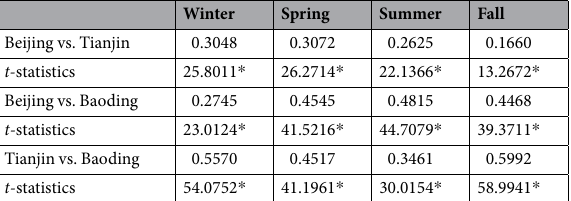
Table 1. Partial correlation coefficients and t -statistics between per two cities of Beijing, Tianjin, and Baoding in four seasons. Note: * Indicates statistical significance with 0.01 significance